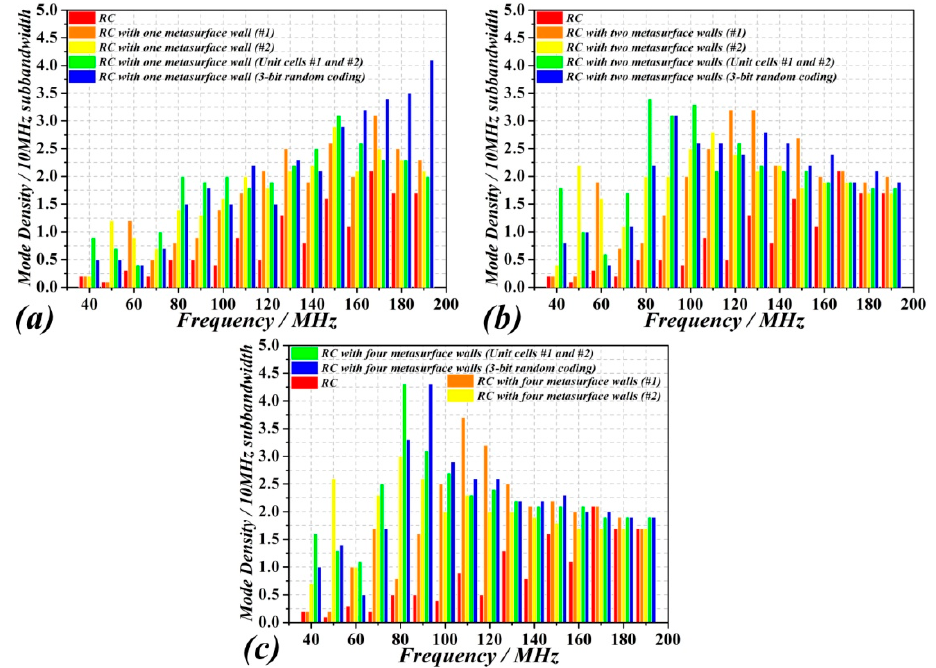
Figure 7. Mode density of the metallic RC compared with the RC with one metasurface wall ( a ), with two metasurface walls ( b ), and with four metasurface walls ( c ).